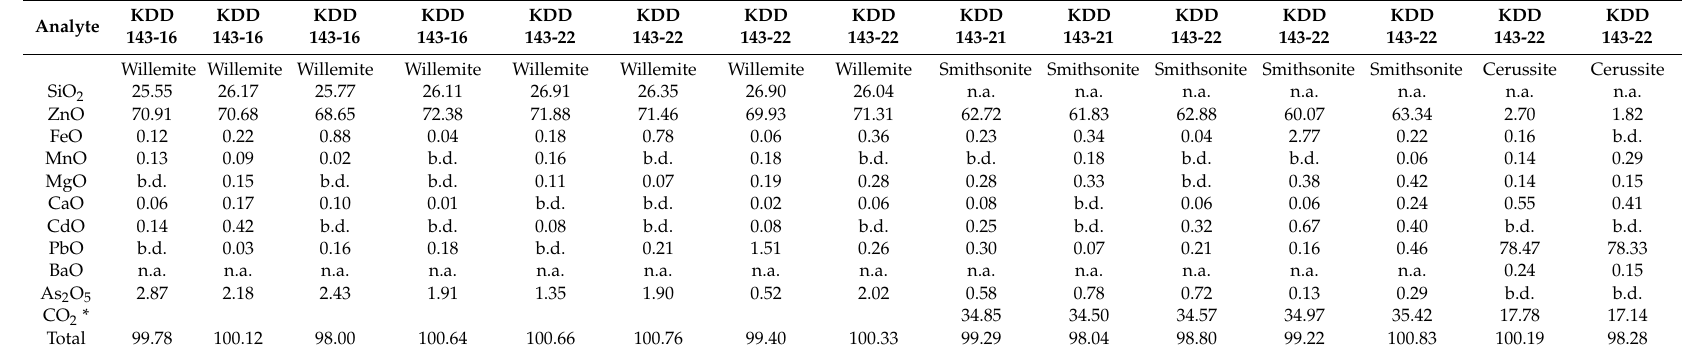
Table A1. Representative chemical compositions of willemite, smithsonite and cerussite (SEM-EDS).